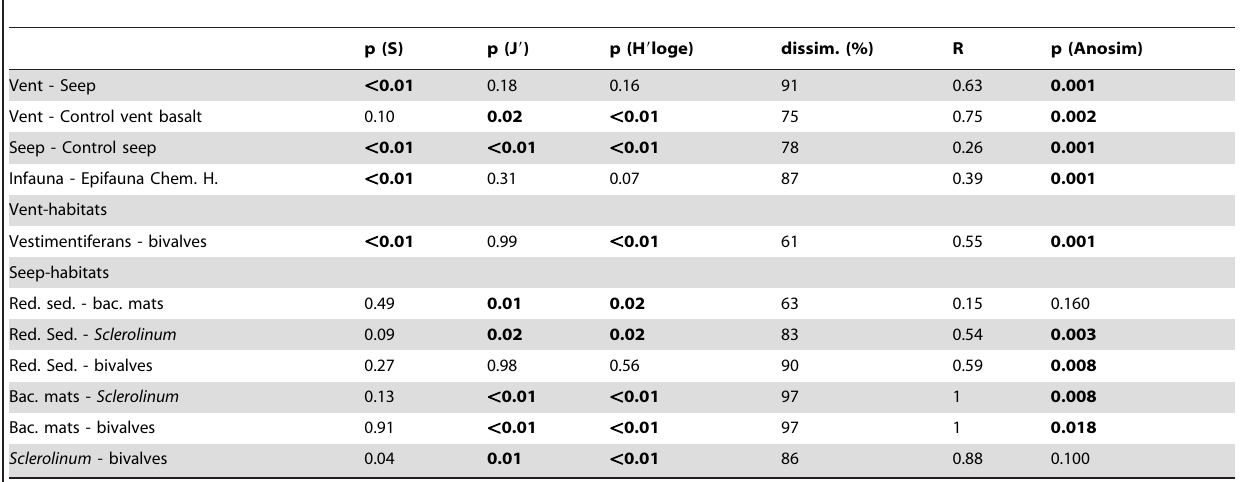
Table 6. Results of student’s t-test (p) are given for genera richness (S), Pielou’s evenness (J 9 ), and Shannon diversity index (H 9 loge ).